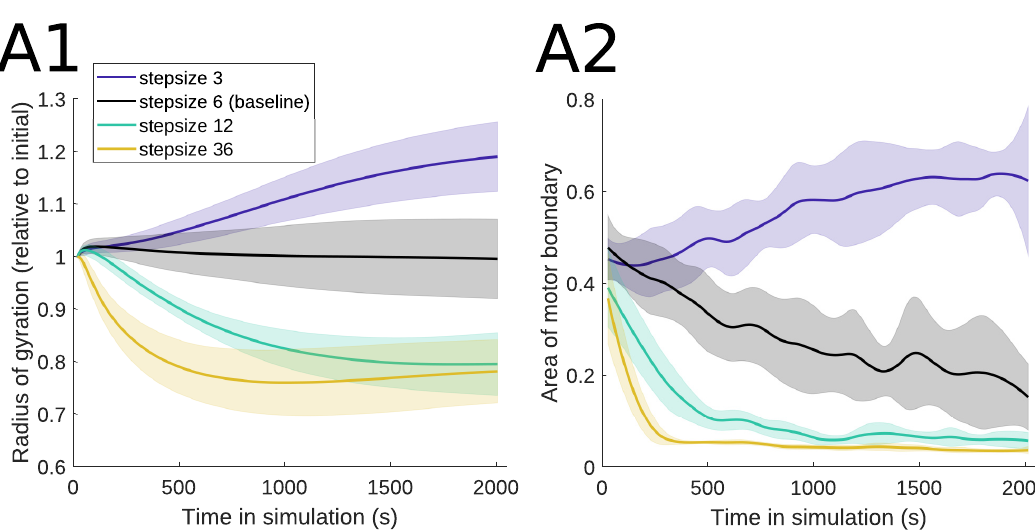
Fig 5. Actin and myosin organization is consistent across simulations for varying myosin step sizes. (A1) The radius of gyration decreases as motor step size is increased, reflecting the formation of actin clusters (Fig 4A). (A2) The area of the polygon enclosing the motor proteins also decreases as motor step size increases, due to motor proteins binding to clustered actin filaments. The parameter values used are k head,bind = 0.2/s, F s = 100 pN, range heads = 15–30 (see Table 1). Solid lines indicate the average and shaded areas indicate the standard deviation over 10 stochastic runs. See Fig 3 for additional measure